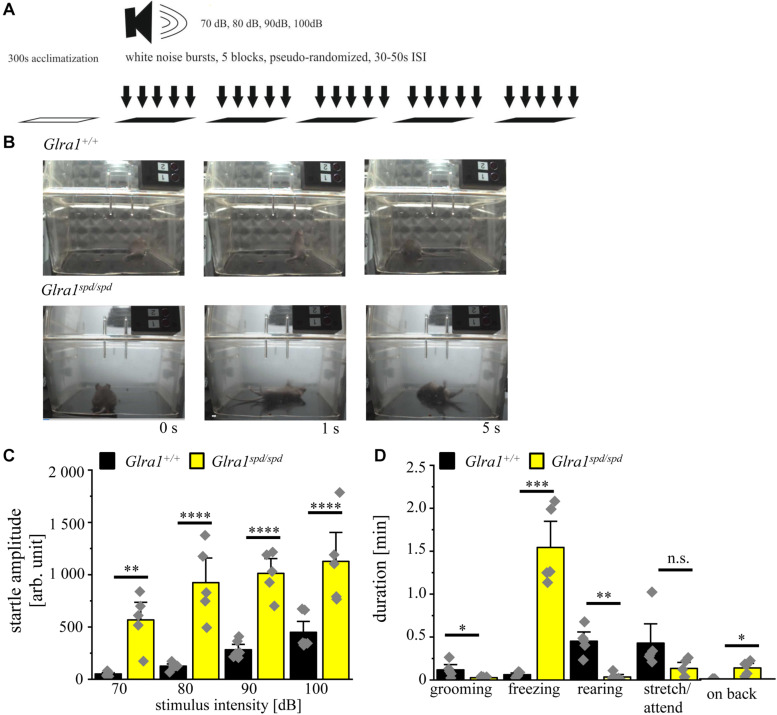
Homozygous spasmodic mice show extensive startle reactions. (A) Schematic overview of the conducted startle test. After 300 s of acclimatization, five blocks with white noise bursts of 70–100 dB in pseudo-randomized order were applied with 30–50 s pause between blocks. (B) Representative images of Glra1+/+ and Glra1spd/spd animals during startle test. Note that Glra1spd/spd fall on their back immediately after the tone due to evoked startle responses. (C) Startle amplitude of Glra1spd/spd (n = 5, yellow bars) and Glra1+/+ (n = 6, black bars) animals during behavioral startle test are depicted with increasing stimulus intensities (70–100 dB). (D) Times spent grooming, freezing, rearing, stretch/attend, and laying on back of Glra1spd/spd (n = 5, yellow bars) and Glra1+/+ (n = 6, black bars) animals were tracked during the startle test (1110 s). Level of significance refer to ∗p < 0.05, ∗∗p < 0.01, ∗∗∗p < 0.001, ****p < 0.0001. Gray squares refer to single data points.